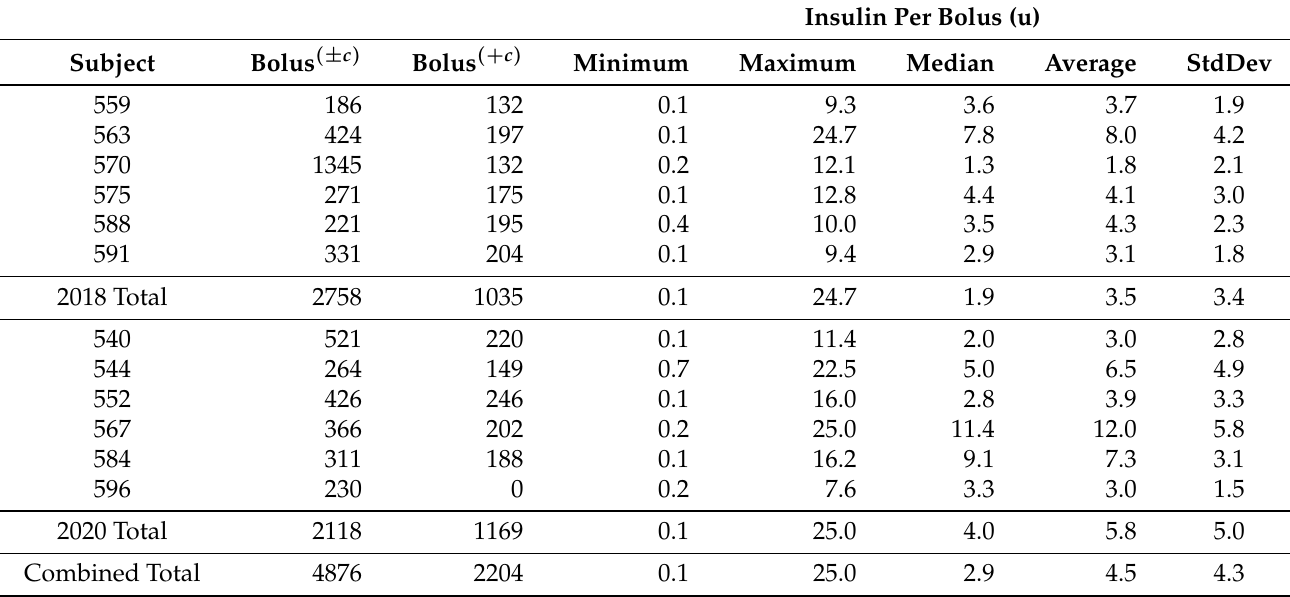
Table 2. Per subject and total boluses and insulin units statistics: Minimum, Maximum, Median, Average, and Standard Deviation (StdDev). Bolus ( ± c ) refers to all bolus events; Bolus (+ c ) refers to bolus events associated with a meal. Statistics are shown for the 2018 subset, the 2020 subset, and for the entire OhioT1DM